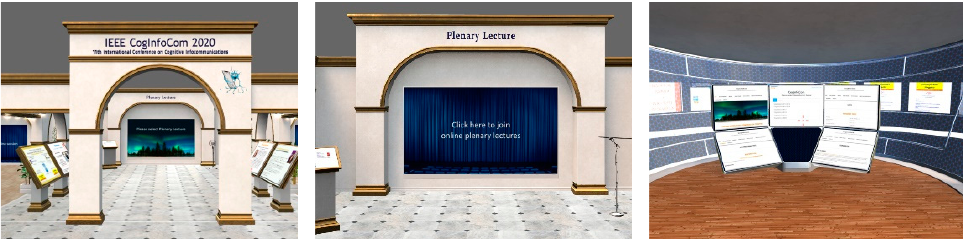
Figure 2. The 11th IEEE International Conference on Cognitive Infocommunications conference presentations were seen by participants in 3D virtual space.